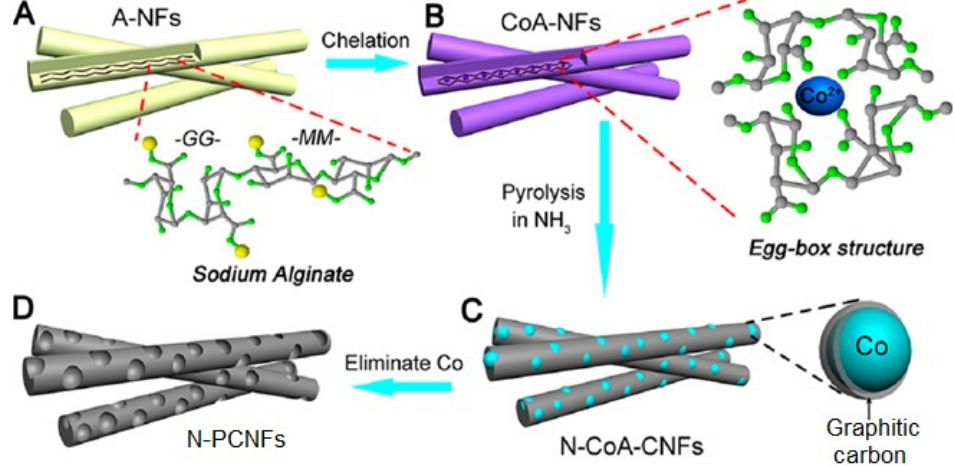
Figure 2. Schematic illustration of the synthesis process of N-doped porous graphitic carbon nanofibers (N-PCNFs). Reprinted from [63] with permission. Copyright 2015 American Chemical Society.